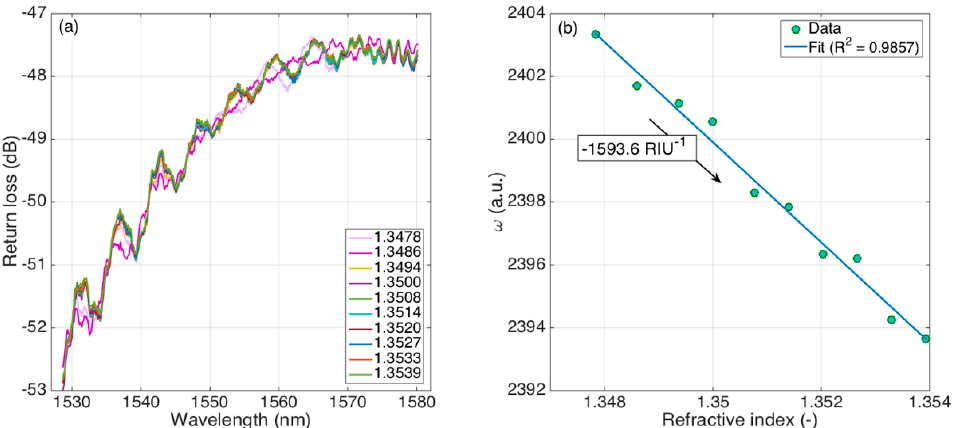
Figure 6. Refractive index sensitivity of the ball resonator interrogated with the KLT method. ( a ) Reflection spectra of the ball resonators, for different RI values ranging from 1.3478 to 1.3539. ( b ) KLT output ω as a function of the RI; the linear fit shows the sensitivity as − 1593.6 RIU − 1 .